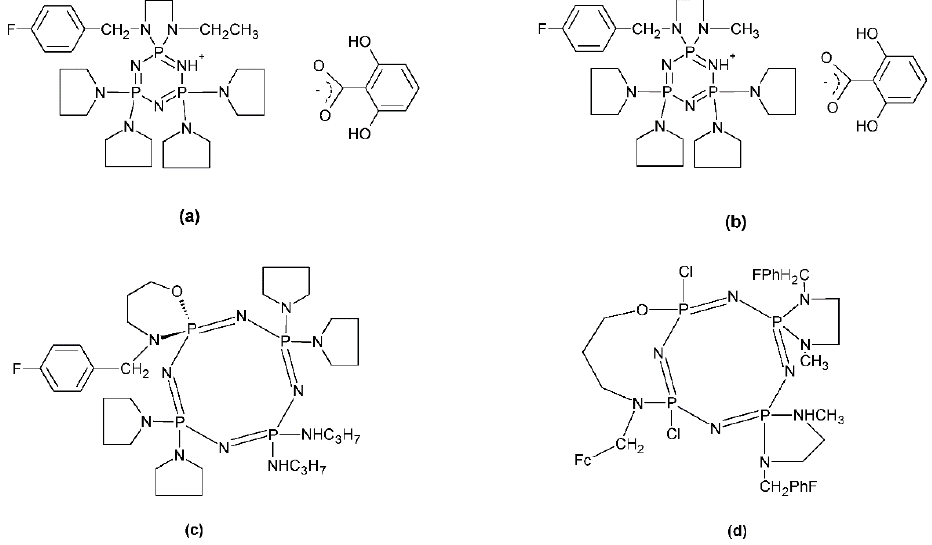
Figure 8. ( a , b ): Protic phosphazene salts; ( c , d ) Neutral cyclotetraphosphazenes. (Fc=Ferrocenyl). Tetramers similar to compound ( c ) showed greater inhibitory activity against K.